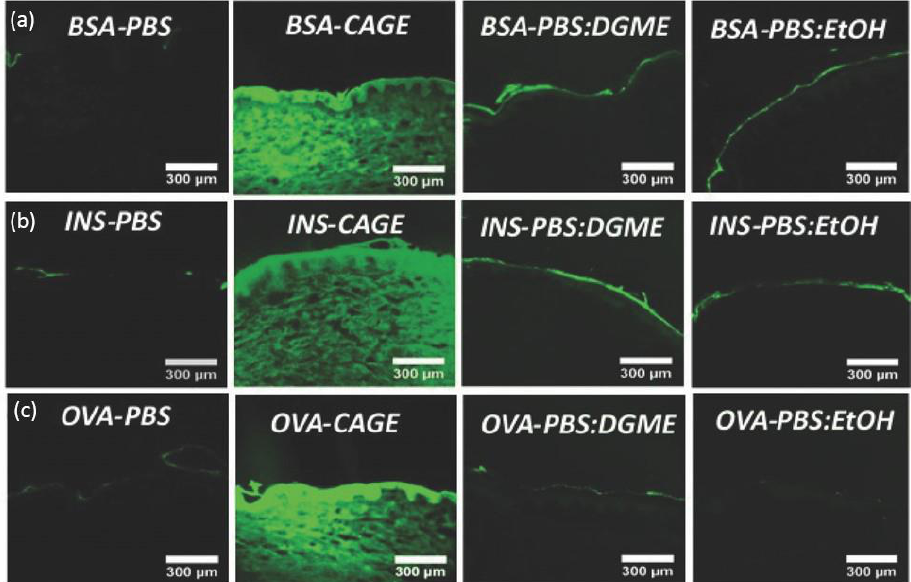
Figure 2. In vitro skin penetration of ( a ) FITC-BSA, ( b ) FITC-Insulin, and ( c ) FITC-OVA in PBS, CAGE, 50:50 ( v / v ) PBS/DGME, and 50:50 ( v / v ) PBS/ethanol, respectively. BSA — bovine serum albumin; INS — insulin; OVA — ovalbumin; PBS — phosphate buffered saline; DGME — diethylene glycol monoethyl ether (reproduced with permission from Banerjee et al., Advanced Healthcare Materials; published by Wiley, 2017) [55].